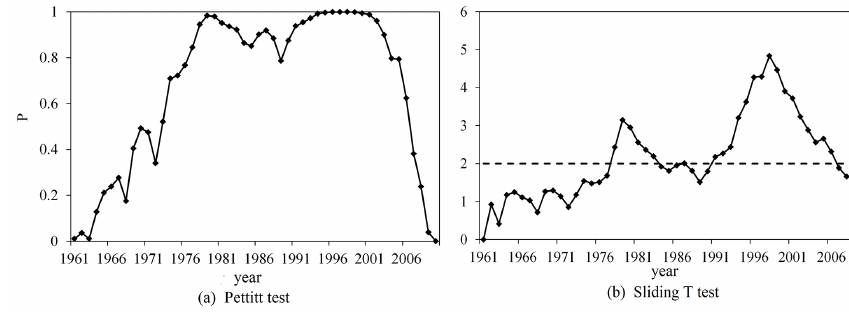
Figure 2. The change points of the runoff series. Table 4. HI-12 monthly mean and standard deviation (SD).